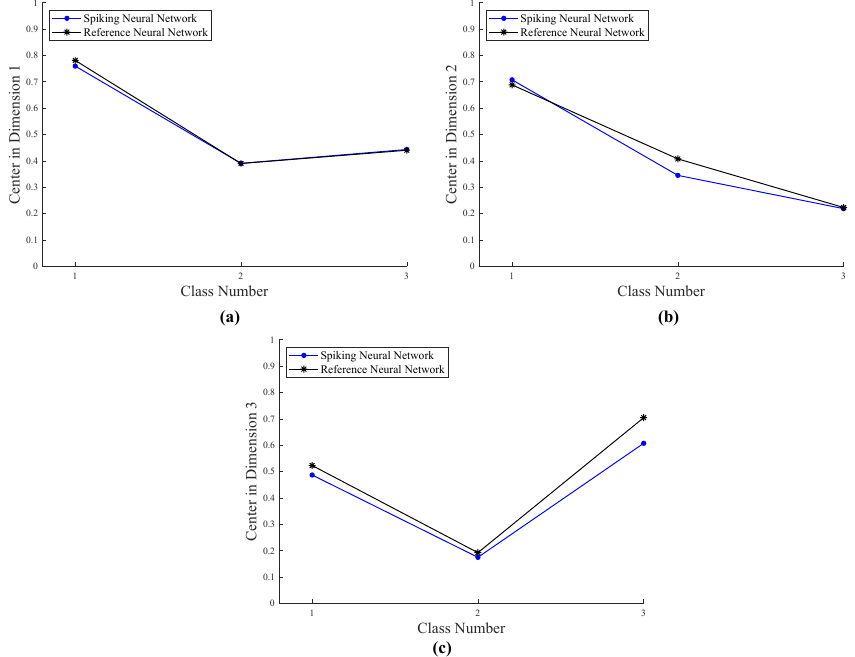
Figure 10. Values of Centers. ( a ) Value of Centers in Dimension 1. ( b ) Value of Centers in Dimension 2. ( c ) Value of Centers in Dimension